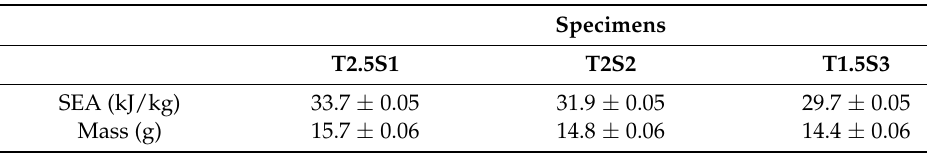
Table 8. Energy absorption capabilities.